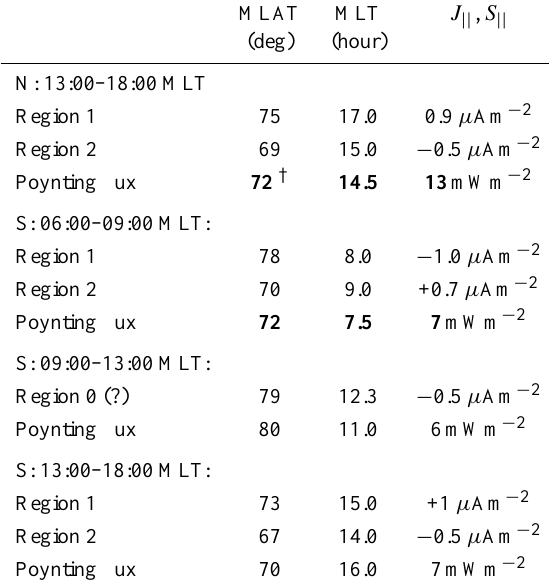
Table 3. Locations of the maximum and minimum FACs, and the maximum downward Poynting flux for regions of enhanced